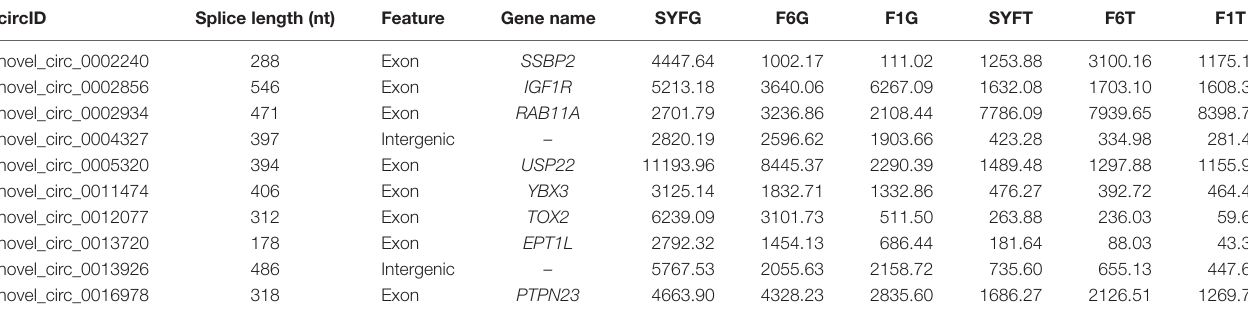
TABLE 2 | Top 10 differentially expressed circRNAs in granulosa cells. circID Splice length (nt)